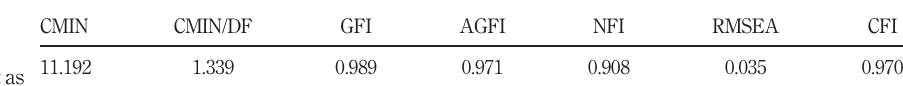
Table 8. Values of model fi t as obtained from structural equation modeling